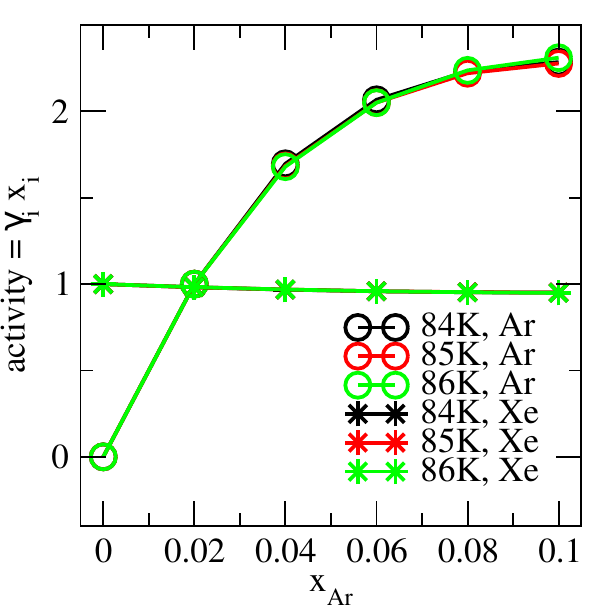
Figure 9. Activity of Ar and Xe as a function of the Ar concentration. Note that the reference point is x Ar = 0 for Xe, but it is x Ar = 0.02 for